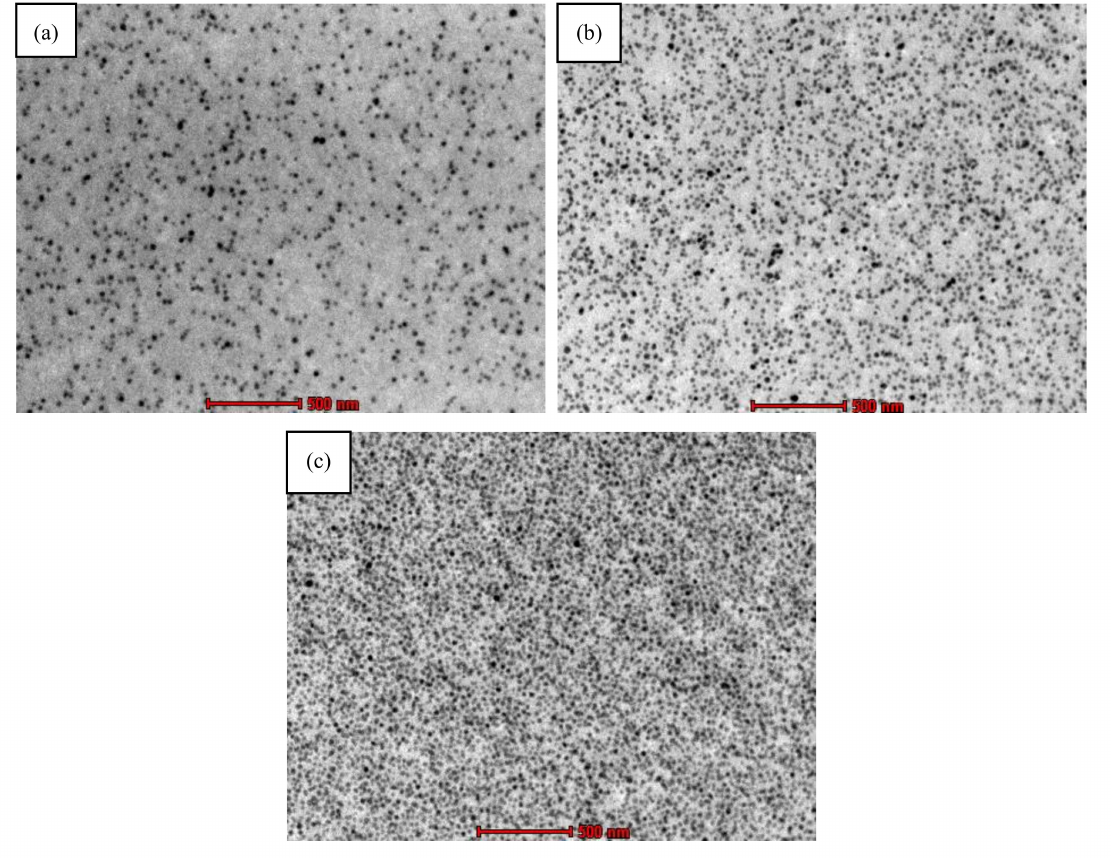
Figure 2. Nanosilica-modified epoxy, viewed under transmission electron microscopy (TEM) at